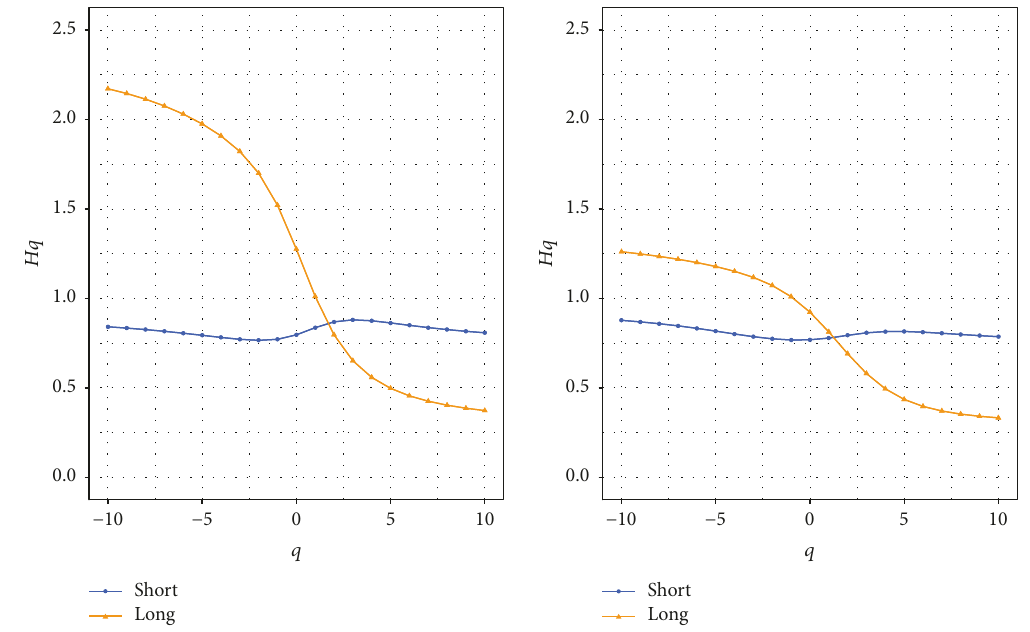
Figure 9: Short and long scaling exponents for news-Return and